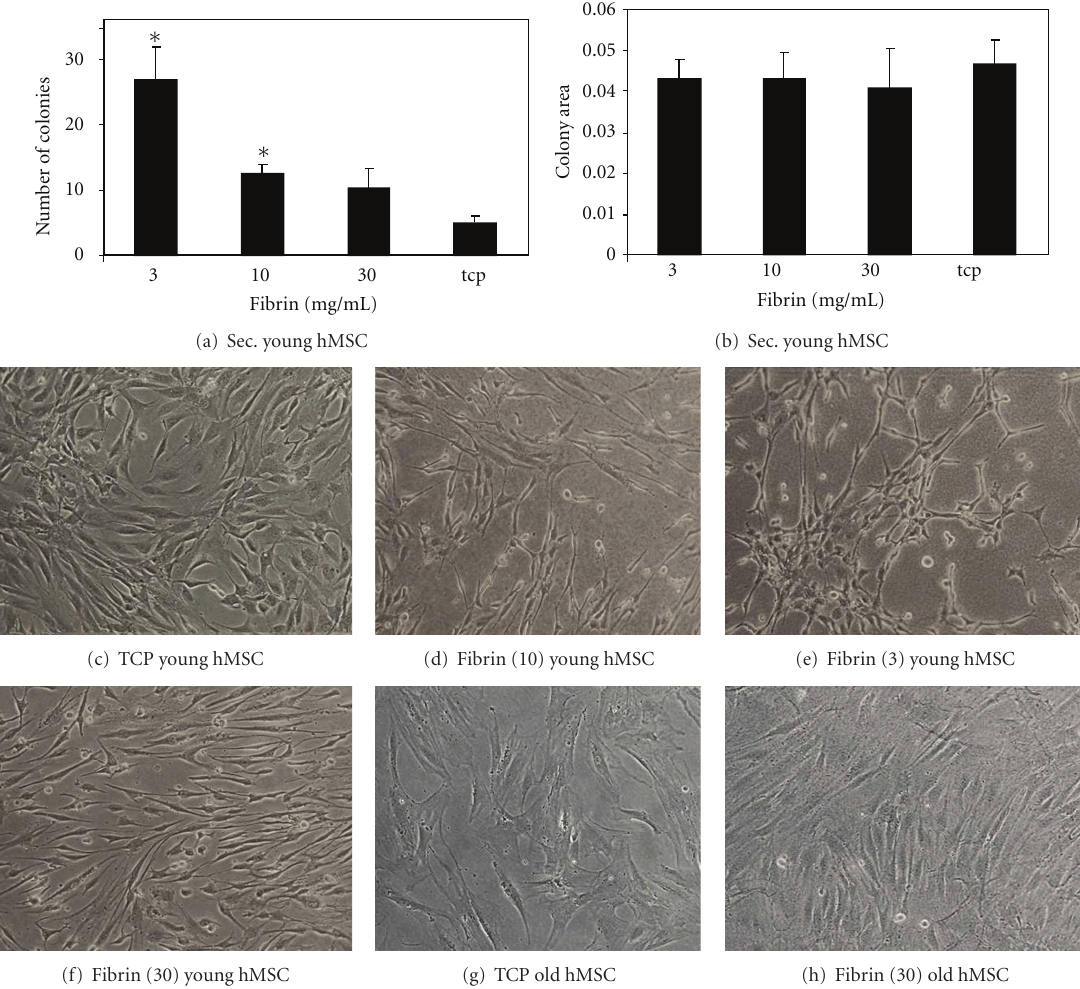
Figure 4: MSC morphology and self-renewal. MSC from an 18-year-old healthy donor were cultured on 10 mg/mL fibrin for 7 days before re-seeding them onto di ff erent concentrations of fibrin or TCP. We call these secondary colonies. The di ff erent surfaces were again tissue culture plastic, 3 mg/mL fibrin gel, 10 mg/mL, and 30mg/mL (d). MSC from a 55-year-old donor are cultured on TCP and 30mg/mL fibrin gel. Colony numbers (a) as well as size (b) are shown and the di ff erent morphologies (c–h) are shown. ∗ Denotes a statistically significant di ff erence from the other